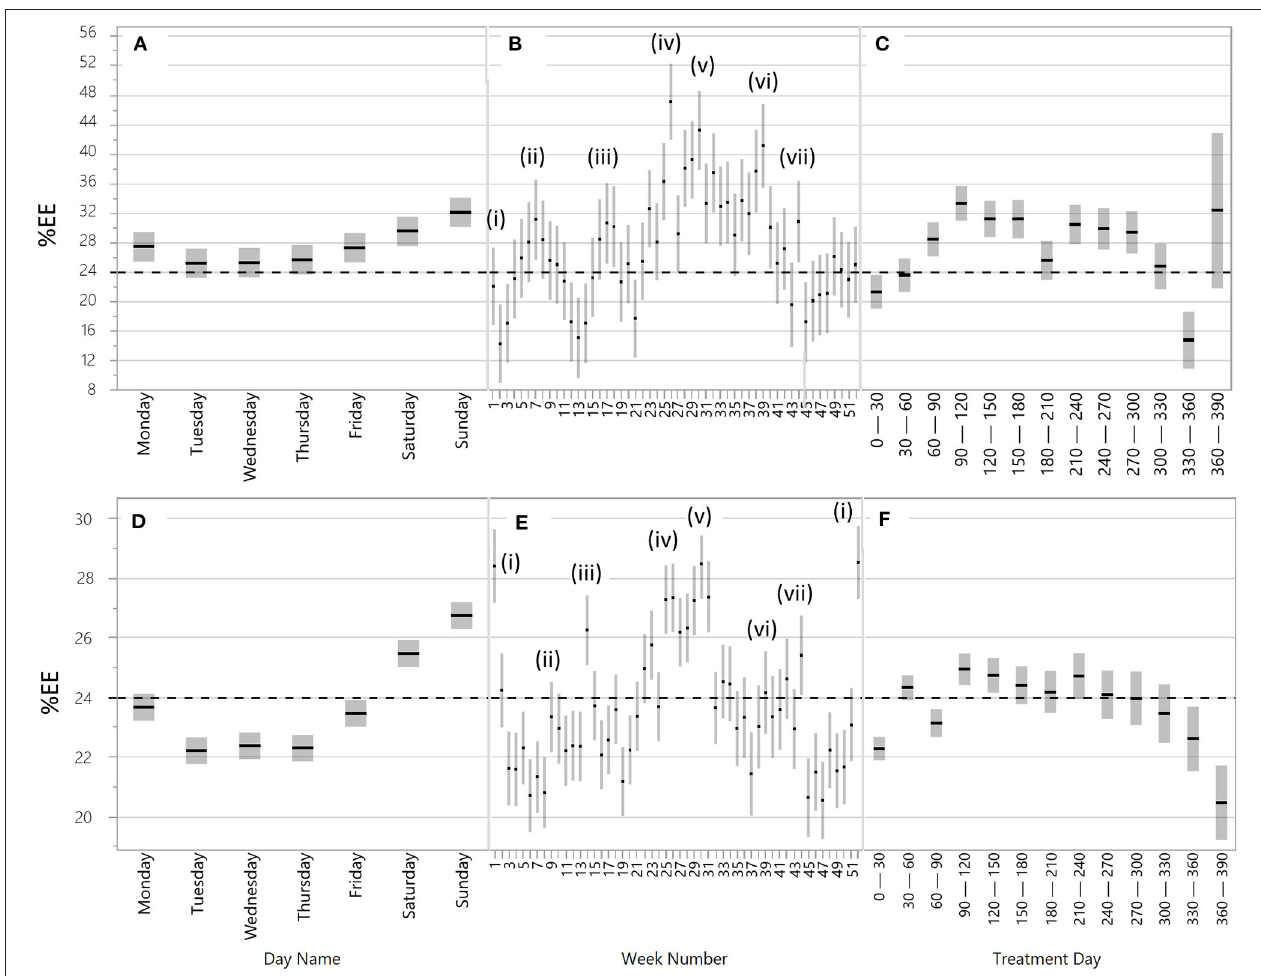
FIGURE 4 | Time-related periodicities and seasonal patterns in exacerbation events (%EE) for the 51 patients from the clinical trials (A–C) and for 1,717 patients from clinical practice (D–F) . Periodicities and seasonal patterns are related to (A) and (D) weekdays (day name); (B) and (E) week numbers, i.e., holidays; and (C) and (F) time from treatment start (treatment days). Explanations of (i–vii) in (B) and (E) : (i) New year and Christmas, (ii) Swedish school winter vacation weeks, (iii) Easter, (iv) Swedish Midsummer, (v) summer vacations, (vi) Swedish moose hunt, and (vii) Halloween and Swedish school autumn vacation week. The line at y = 24 is included to enhance the comparison between the groups of patients (A–C) vs. (D–F) . Note that the y-axis has a different range in (A–C) vs. (D–F)